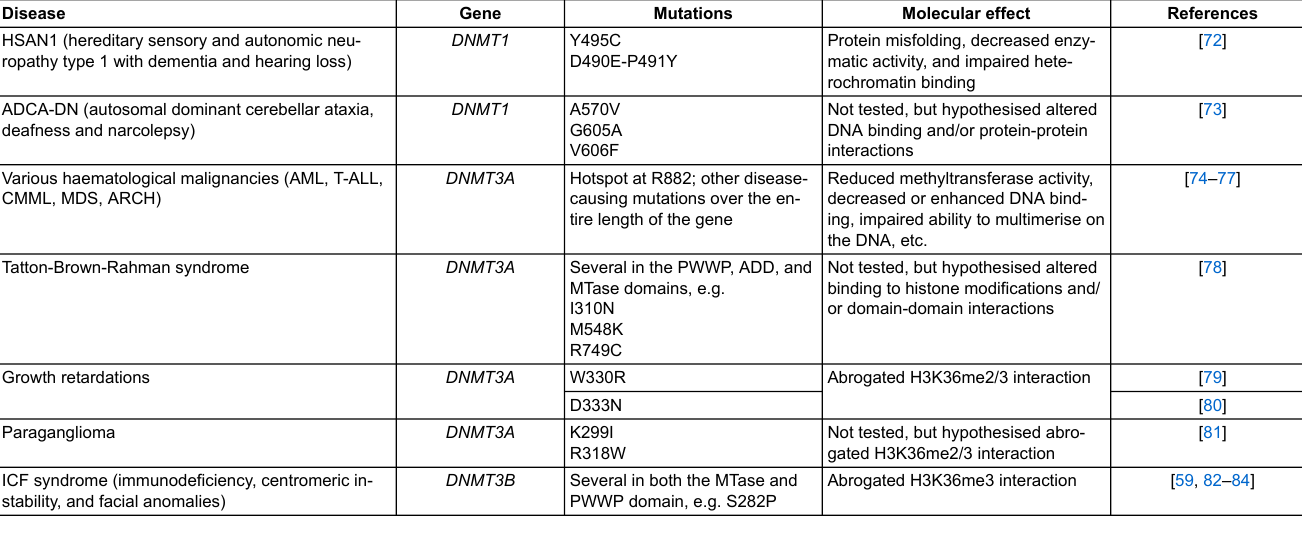
Table 1: Diseases associated with aberrant DNMT recruitment. Disease Gene